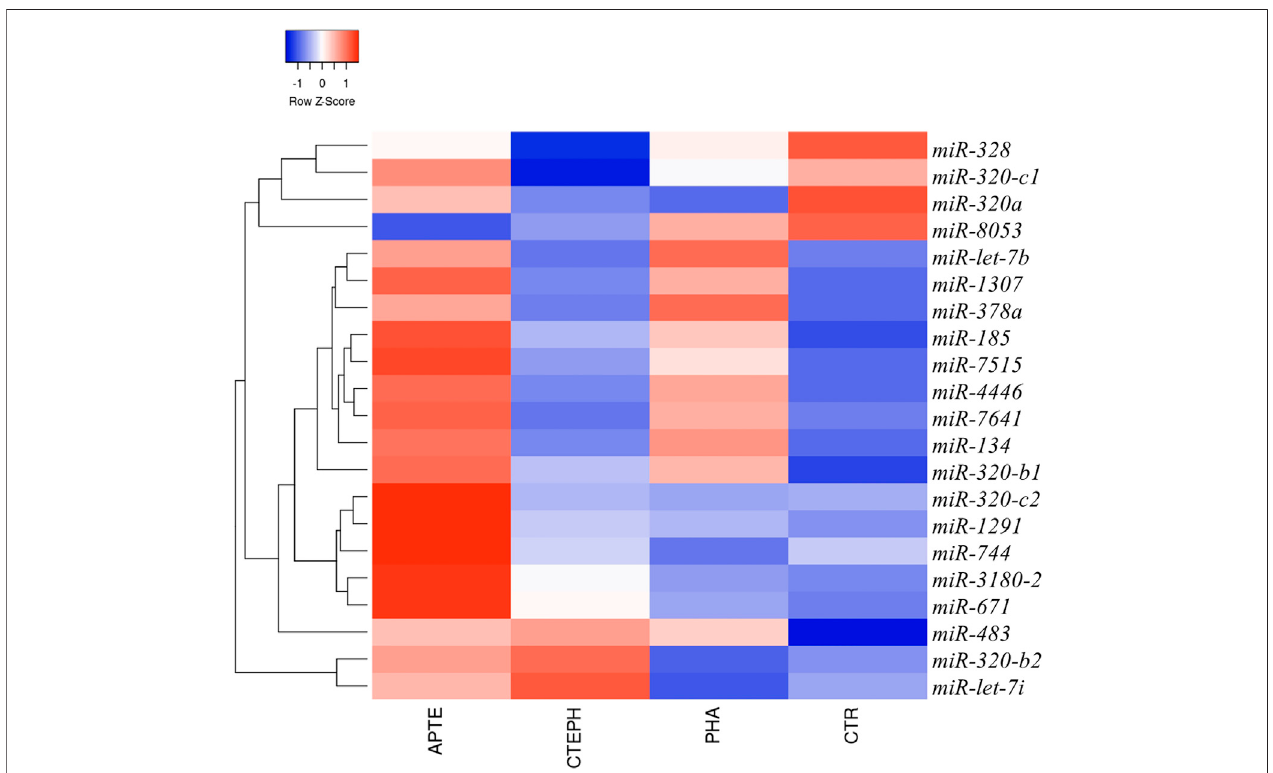
FIGURE 2 | Circulating miRNAs signature in APTE, CTEPH, PAH patients, and healthy controls. Hierarchical clustering and heatmap diagram of the optimum circulating miRNAs from APTE ( n (cid:2) 7), CTEPH ( n (cid:2) 8), PAH ( n (cid:2) 5), and healthy controls ( n (cid:2) 2). Green and red colors represent increased and decreased expression levels (transformed into z -scores), respectively, when compared with the average level of each miRNA. Columns and lines represent samples and miRNA, respectively. APTE, Acute Pulmonary Thromboembolism; CTEPH, Chronic Thromboembolic Pulmonary Hypertension; PAH, Pulmonary artery Hypertension; and CTR,